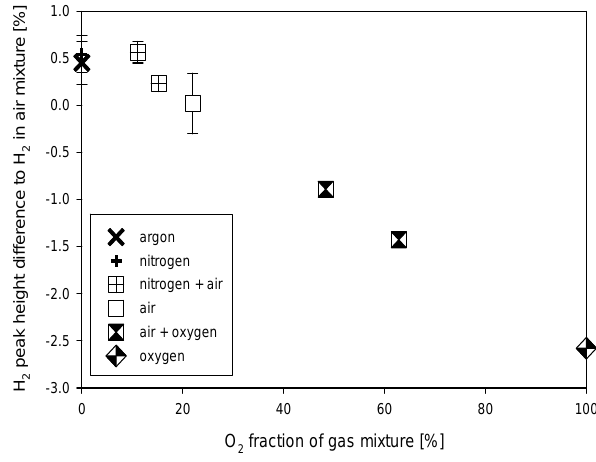
Fig. 8. Residuals for various regression functions through the set Figure 8. Residuals for various regression functions through the set of H 2 -in-air mixtures. 2 of H 2 -in-air mixtures. Displayed is the difference: (H 2 amount Displayed is the difference: (H 2 amount mixed) - (measured H 2 mixing ratio) based on the 3 mixed)–(measured H 2 mixing ratio) based on the respective regres- respective regression function 4 sion function.